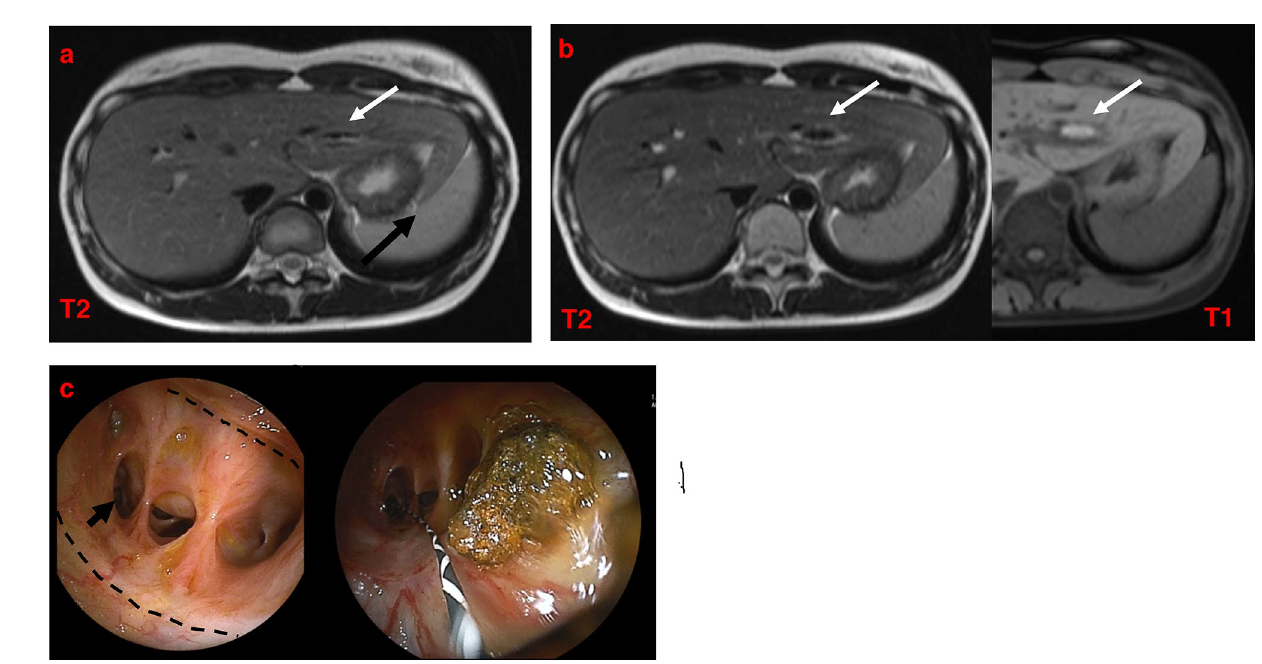
Figure 1. Case 6 from Table 1. ( a ) No abnormalities are seen in MRCP 20 years after radical surgery. ( b ) Twenty-five years after radical surgery, MRCP identifies intrahepatic bile duct dilatation and stones. ( c ) Bile duct mucosa is found in front of the stenosis. There is no stenosis at the anastomosis (dotted line). The stricture is noted in the second part of the bile duct. (arrow) Lithectomy is performed at DBERC. DBERC double-balloon endoscopic retrograde cholangiography, MRCP magnetic resonance